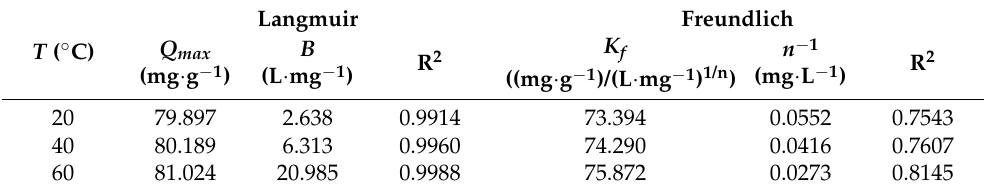
Figure 8. Linear fitting of ( a ) Langmuir model and ( b ) Freundlich model. Table 2. Fitting results of isothermal equation at different temperatures.